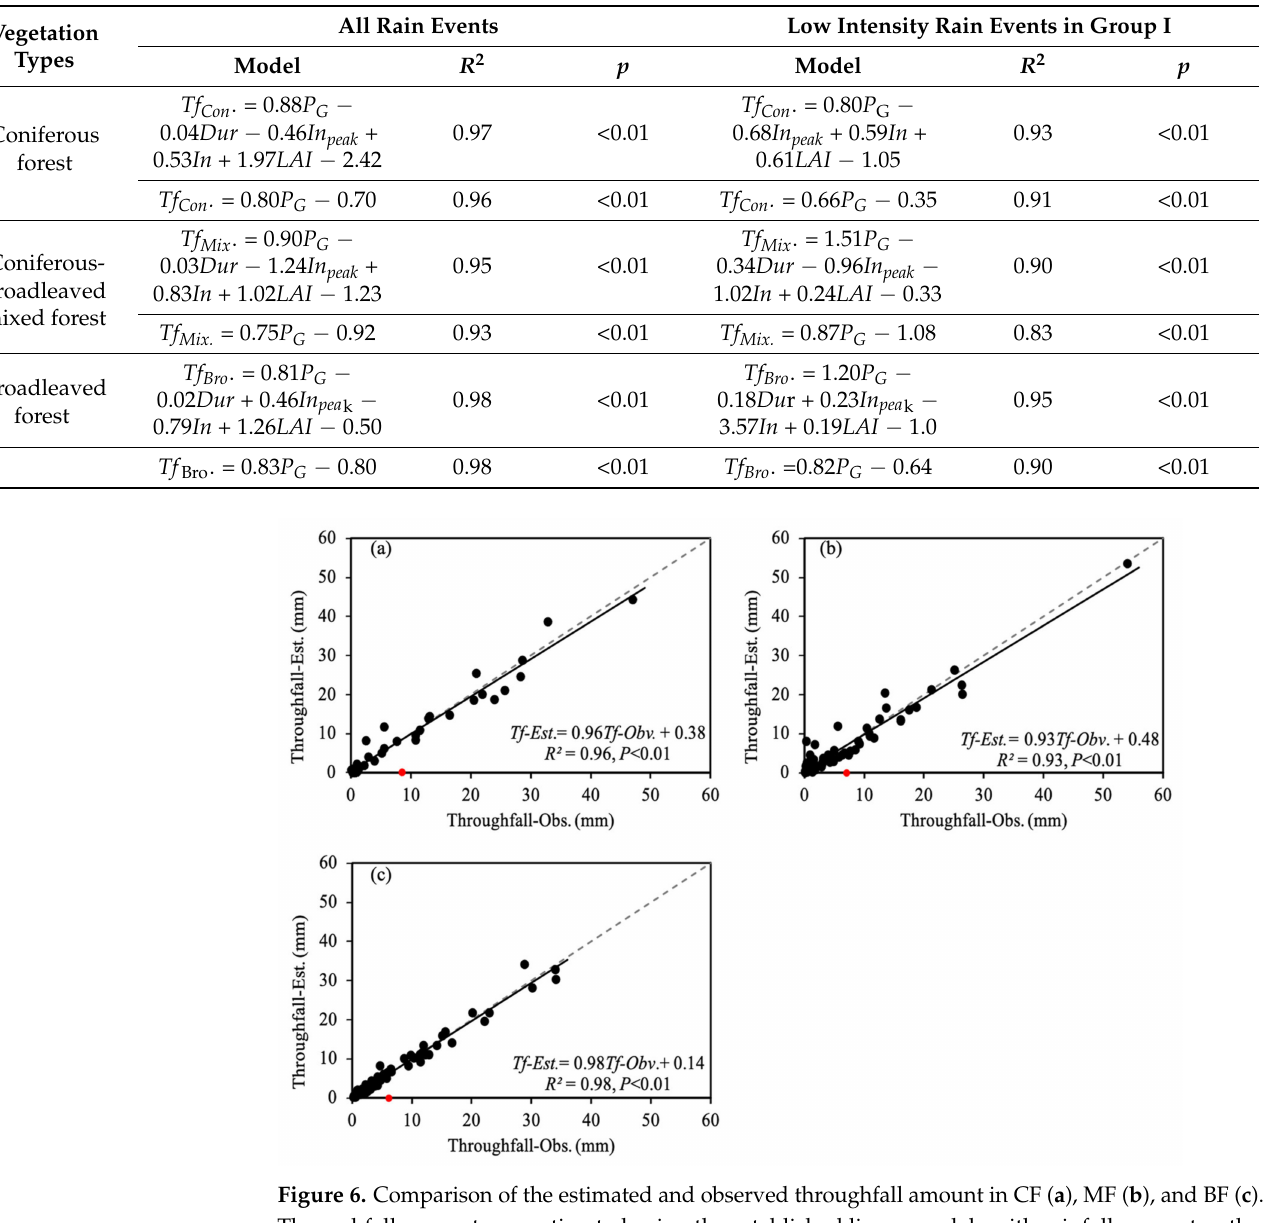
Table 3. Multi-variable linear models relating throughfall amount to rainfall parameters and LAI in comparison with single-variable linear models relating throughfall to rainfall amount for all rain events or light rain events in Group I in CF, MF, and BF.